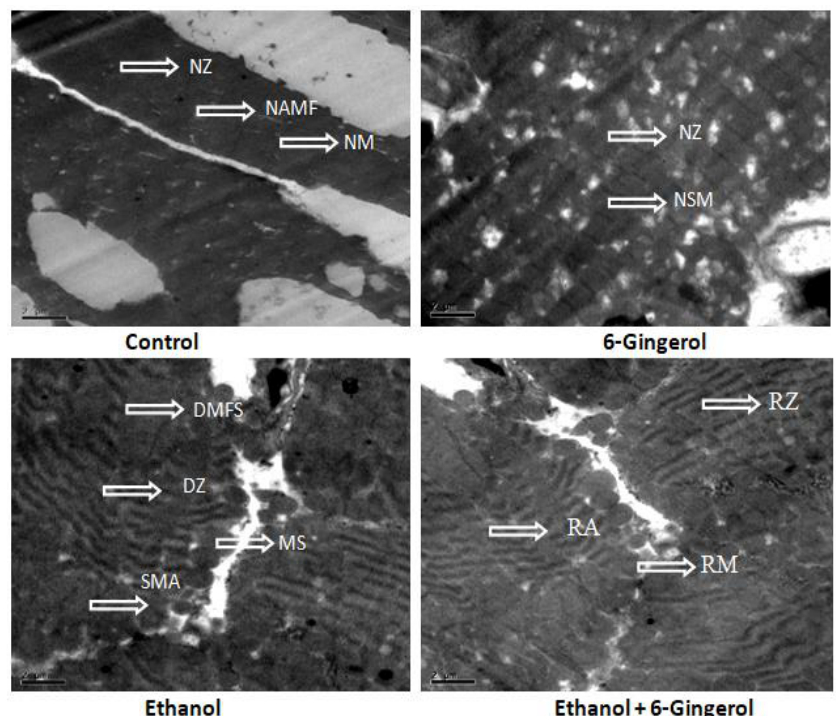
Figure 7. Transmission electron microscopy images of cardiac tissue display alcohol-induced tissue damage and 6-gingerol mediated recovery. The arrow indicates normal structure of Z line (NZ), normal architecture of myofibril (NAMF), normal mitochondria (NM) and normal sarcomere (NSM) in control or 6-gingerol groups. The arrow indicates, degeneration of myofibril structure (DMFS), degeneration of Z lines (DZ), sarcomere alteration (SMA) and mitochondria swelling (MS) in ethanol group. The arrows in ethanol plus 6-gingerol group indicate regeneration of Z line (RZ), regeneration of mitochondria (RM) and reappearance of sarcomere (RA).